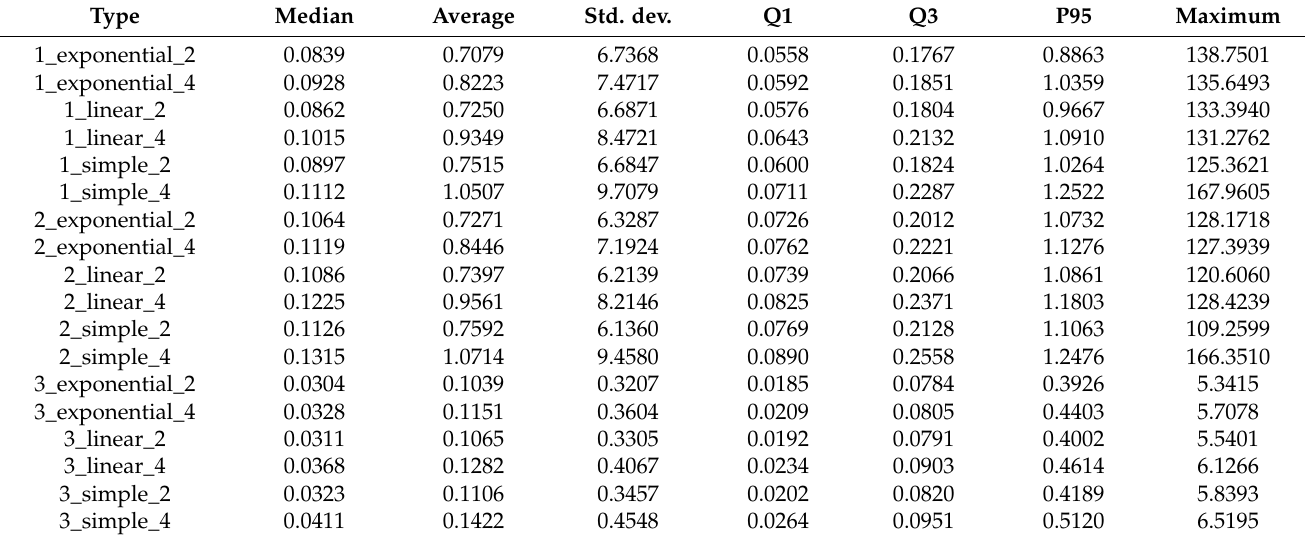
Table 3. MAPE statistics for the second set of missing data (2—continuous).